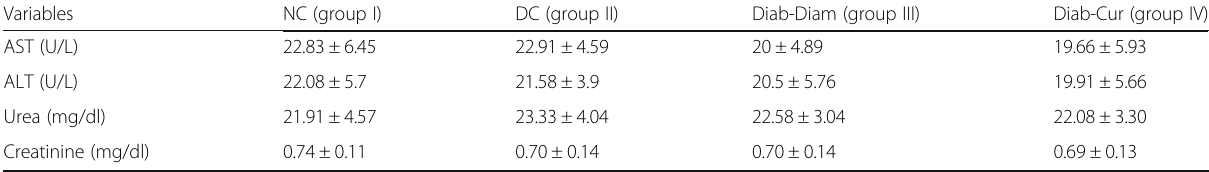
Table 2 Effects of nano-curcumin and Diamicron on liver and kidney functions of Streptozotocin-induced diabetic rats Variables